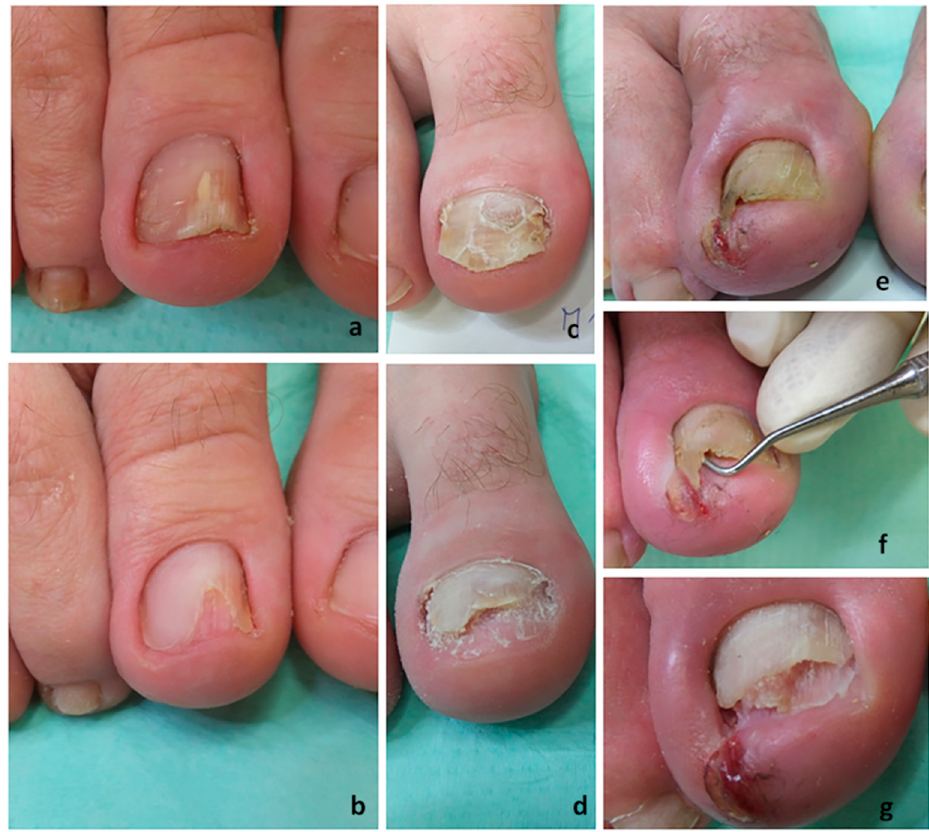
Figure 5. Nail plate abrasion and refreshment: ( a ) A big toenail affected by 50% involvement before NPAR. ( b ) The big toenail at the end of the NPAR procedure. ( c ) A big toenail affected by 75% involvement before NPAR. ( d ) The big toenail at the end of the NPAR procedure. ( e ) An ingrown big toenail affected by onychomycosis. ( f ) Refreshment and collecting subungual debris after abrasion. ( g ) The big toenail at the end of the NPAR procedure. J. Fungi 2020 , 6 , x FOR PEER REVIEW